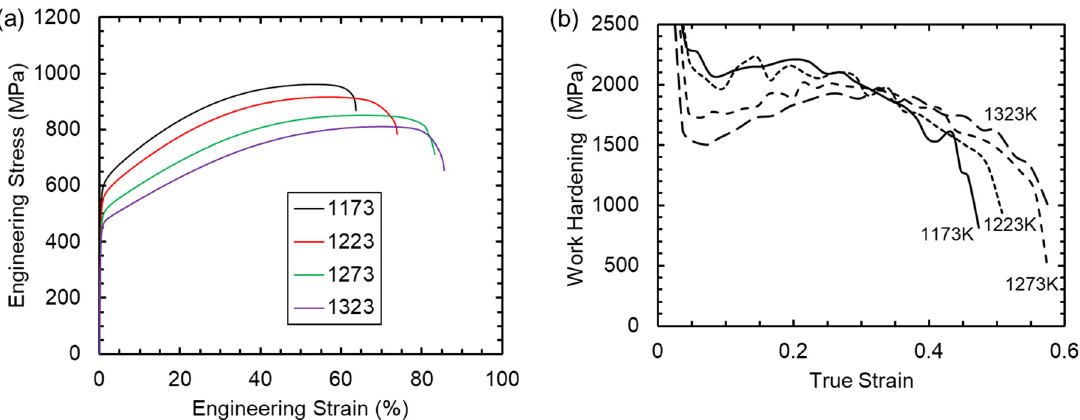
Figure 6. Representative mechanical properties of the steel: ( a ) Engineering stress-strain curves after solution treatment and ( b ) instantaneous work hardening coefficient for the as-solution treated alloy. Table 2. Mechanical properties of the two hour solution treated samples.